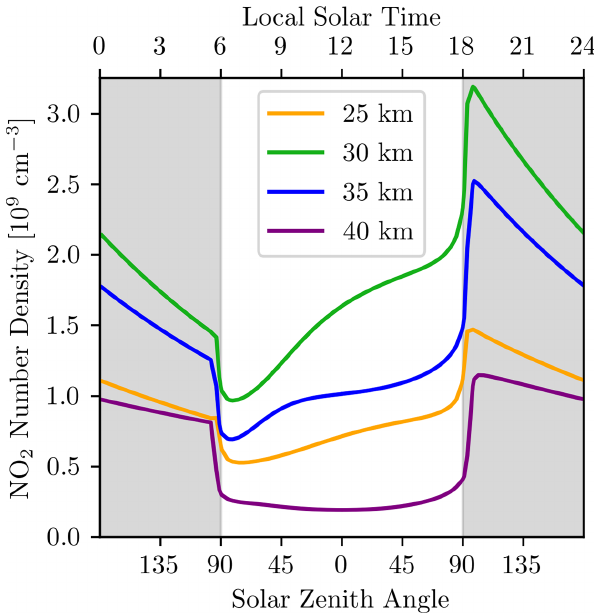
Figure 1. Daily cycle in NO 2 at the Equator as a function of local solar time (top axis) and solar zenith angle (bottom axis) for four altitudes. NO 2 number density calculated with the PRATMO pho- tochemical box